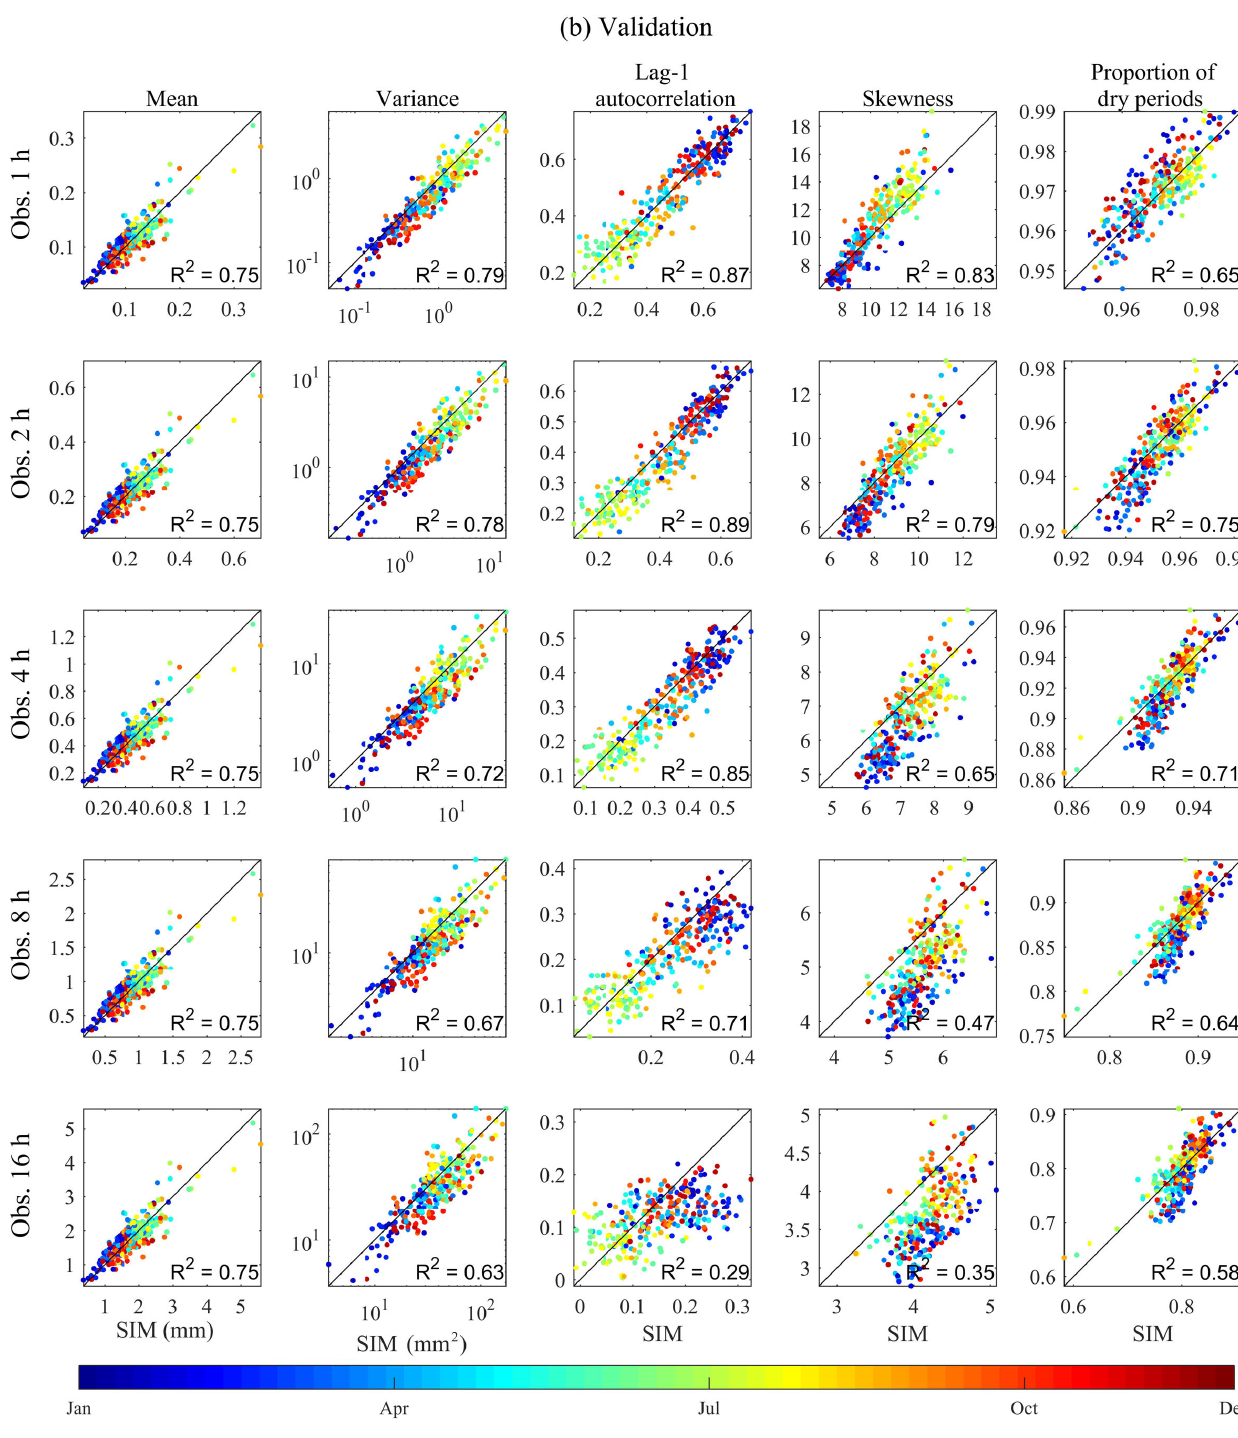
Figure 12. Comparison of the statistics of the synthetic ( x ) and observed ( y ) rainfall time series at sub-daily timescales. The colour of the dots represents the statistics of each calendar month. The results of (a) the calibration period (1981–2010) and (b) the validation period (1951–1980) are